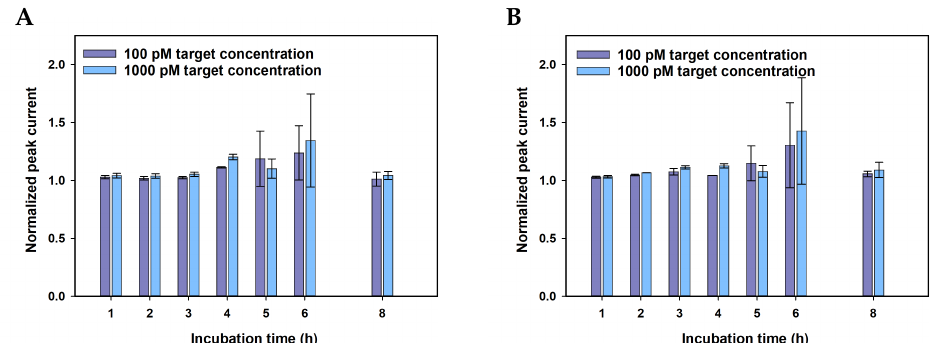
Figure A4. Detection of 100 (purple) and 1000 (blue) pM of the target gene of the target gene with various antibody incubation times (1, 2, 3, 4, 5, 6 and 8 h) using both CV ( A ) and DPV ( B )